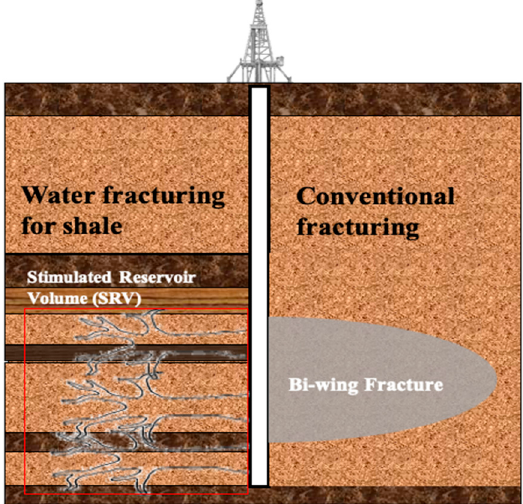
Figure 1. Schematic diagram of different artificial fracture geometry for conventional fracturing and water fracturing.